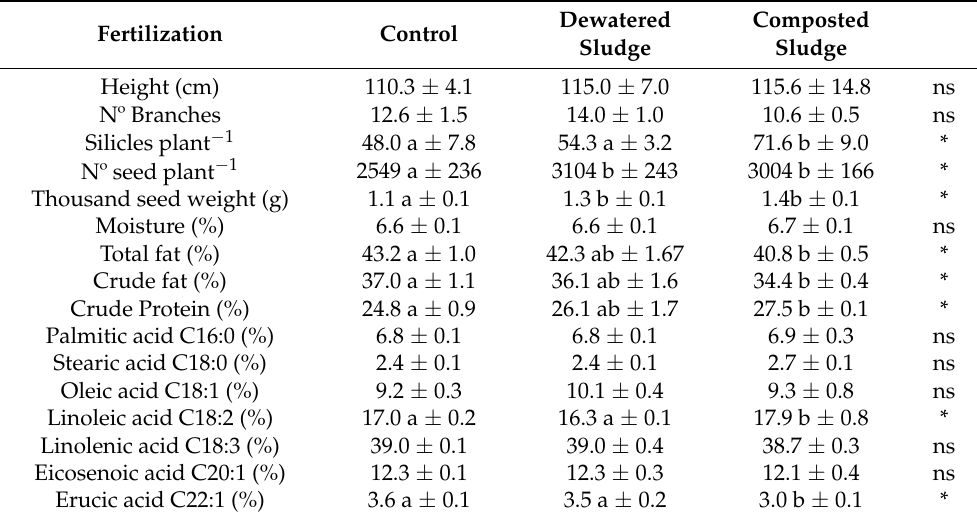
Table 3. Camelina’s yield components considering the three fertilization treatments (dewatered sludge fertilization, composted sludge fertilization, and the control without